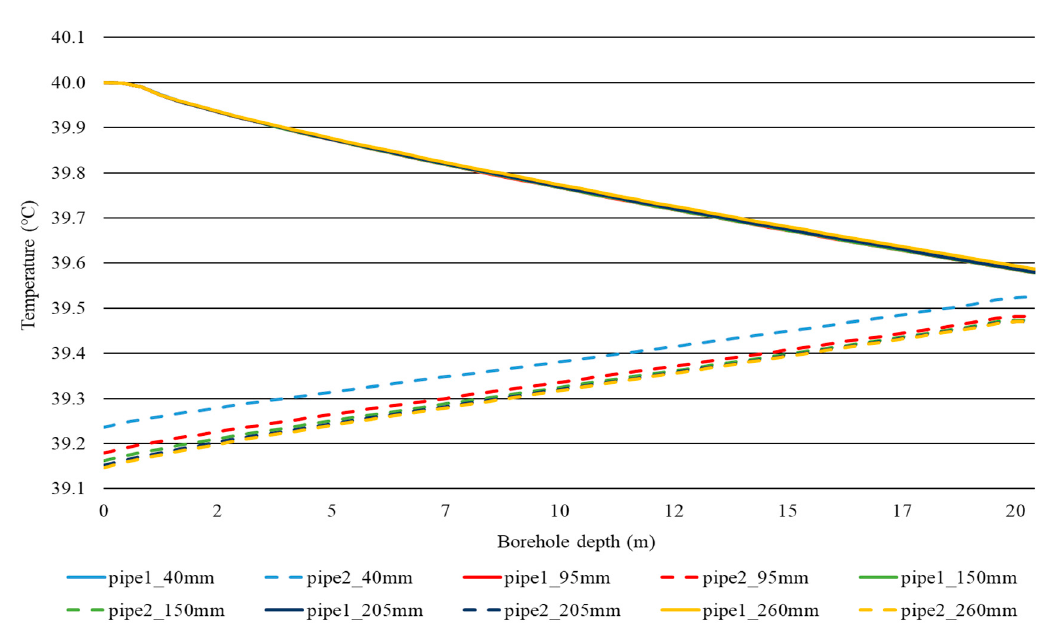
Figure 5. Variation of fluid temperature with depth for the five shank-spaces investigated for the 20 m borehole.